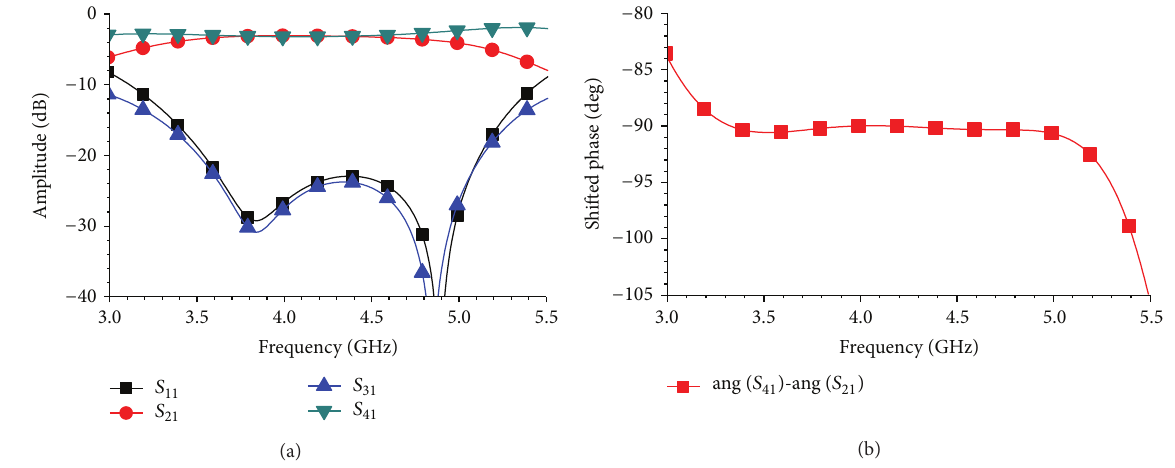
Figure 4: The simulated results of the three-branch line directional coupler: insertion loss and return loss (a) and phase difference performance (b).